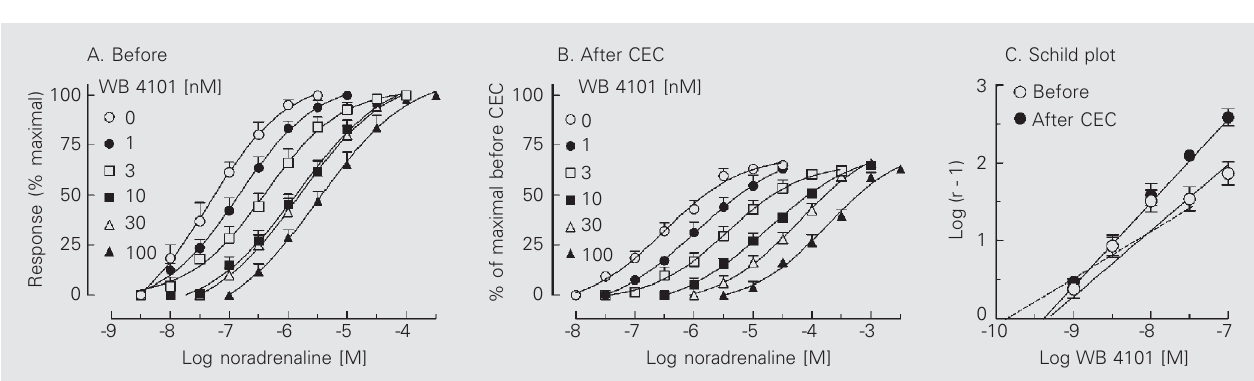
Figure 4. Concentration-re- sponse curves for noradrenaline obtained before (open circles) and after (filled circles) treatment with 100 µM chloroethylcloni- dine (CEC) for 45 min for vas deferens from control (A) and cyproterone acetate-treated rats (B). Each symbol indicates the mean and the vertical line, when larger than the symbol, the SEM of 5-8 measurements on tissue from 4 to 6 rats in each group. When appropriate, rats were treated with cyproterone acetate (10 mg/day, sc ) for 7 days.